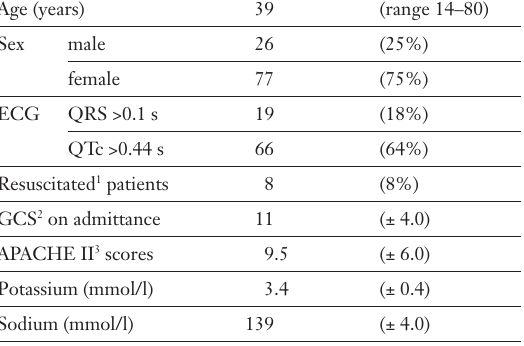
Patient’s baseline